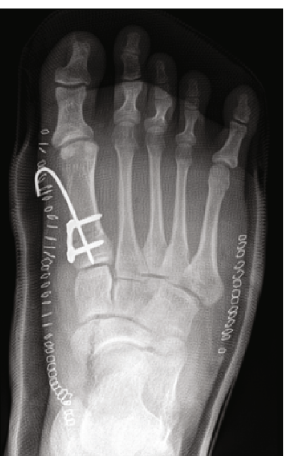
Figure 6: Postoperative posteroanterior radiograph, including plate and K-wire osteosynthesis.